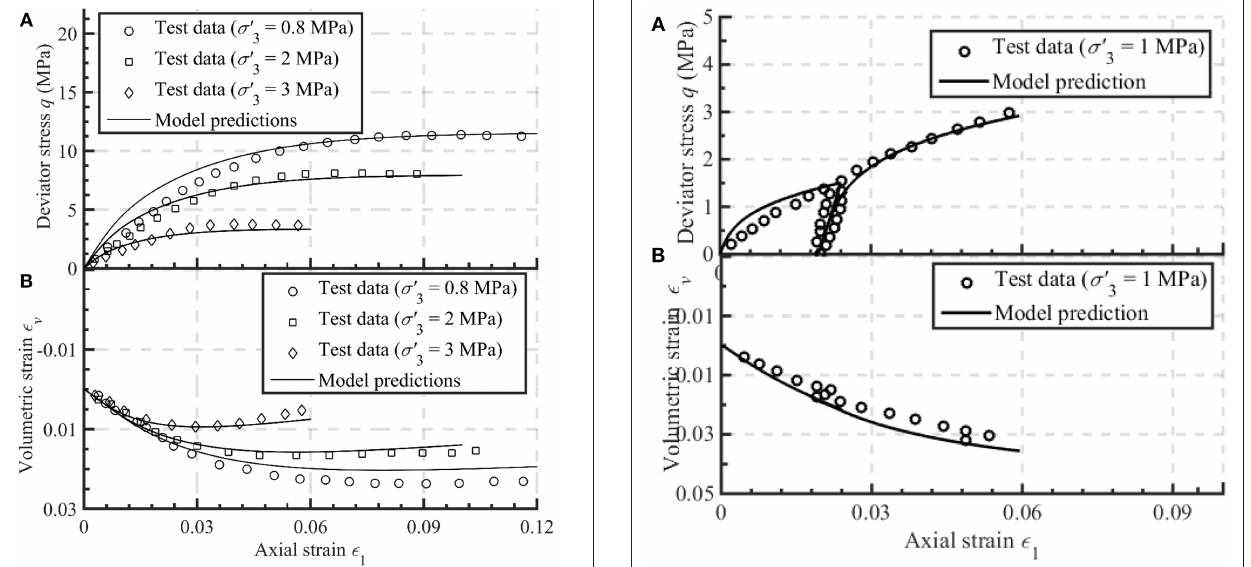
FIGURE 4 | Model prediction of the drained monotonic behavior of Xiaolangdi rockfill (Fu et al., 2014): (A) deviator stress vs. axial strain, (B) volumetric strain vs. axial strain.